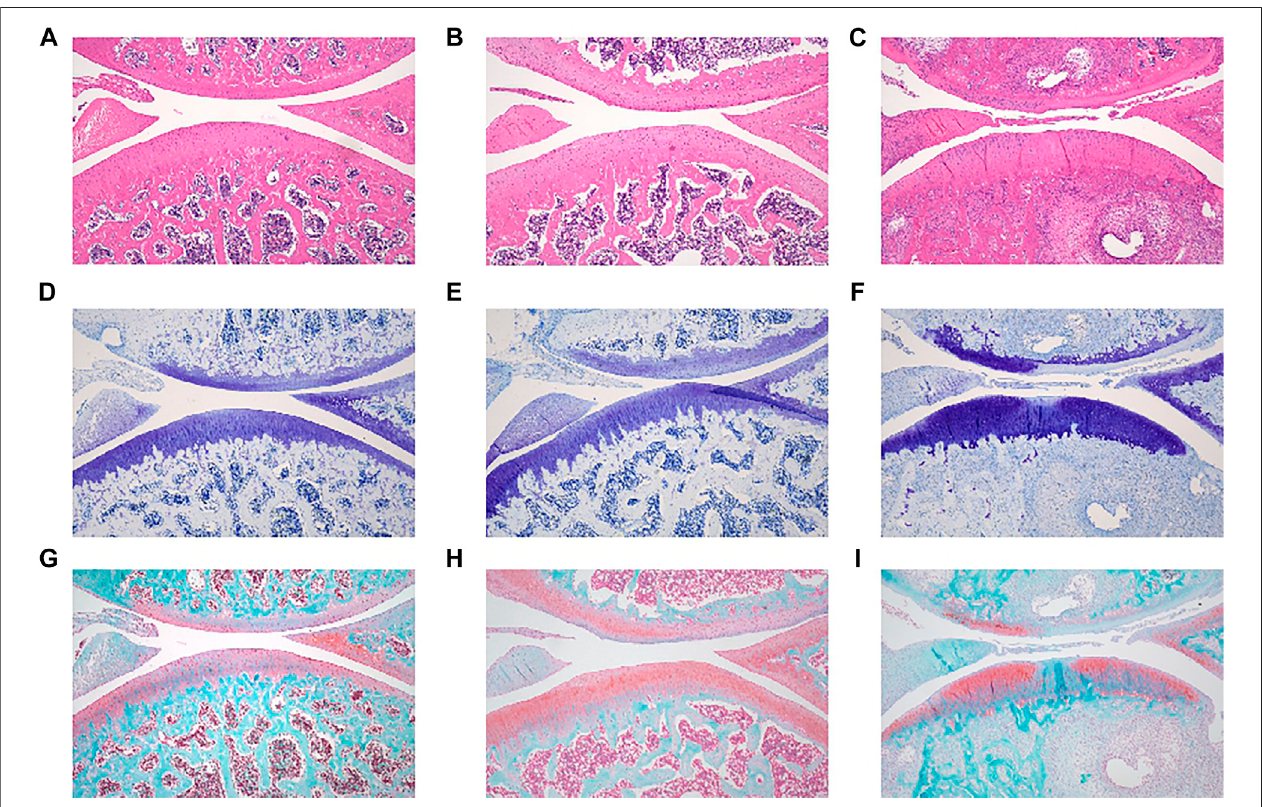
FIGURE4| Representative microanatomicalimagesofcartilagetissuesinthedifferenttreatmentgroupsshowingHEstaining,TBstainingandSO/FGstaining.HE staining of (A) control group, (B) OVX + ACLT, (C) PROTACs + ACLT. TB staining of (D) control group, (E) OVX + ACLT, (F) PROTACs + ACLT. SO/FG staining of (G) control group, (H) OVX + ACLT, (I) PROTACs +